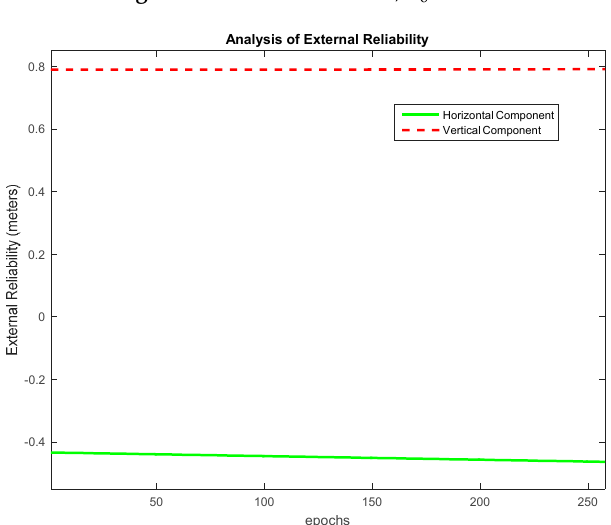
Figure 6. MDB for Dataset 1, α 0 = 1%.